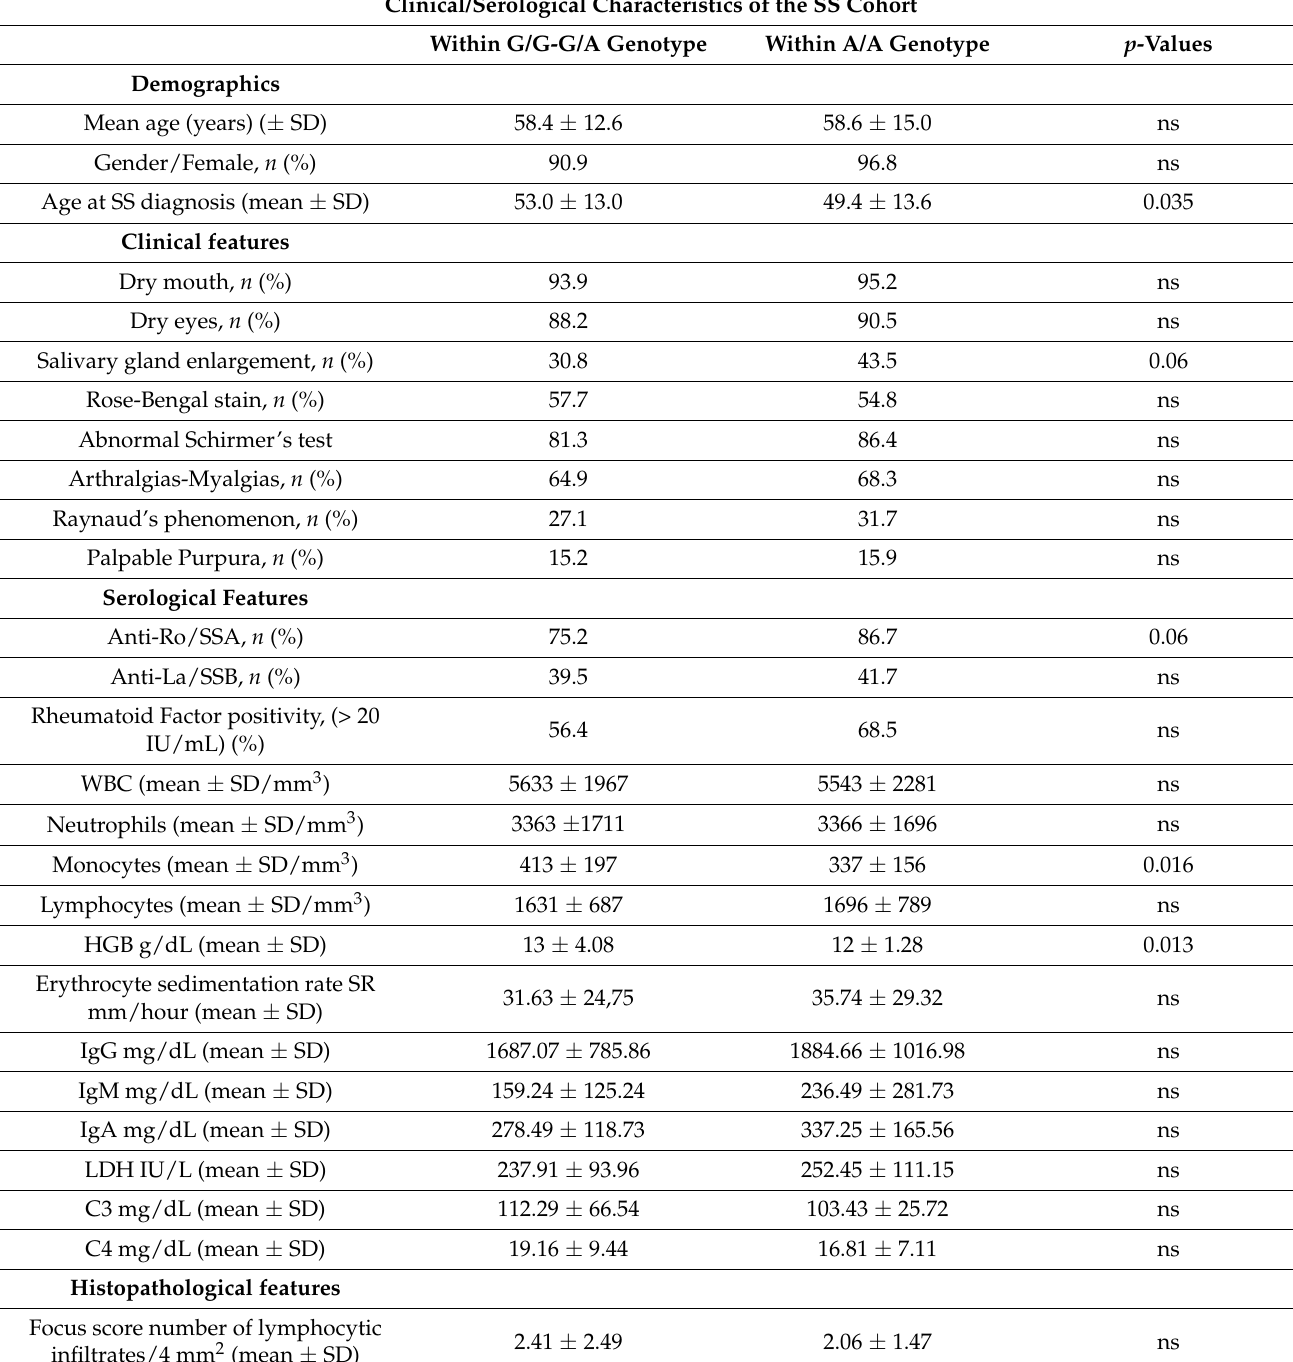
Table 3. Demographic, clinical, histopathological, and serological features of SS patients carrying the G/G-A/A genotype and SS patients carrying the A/A